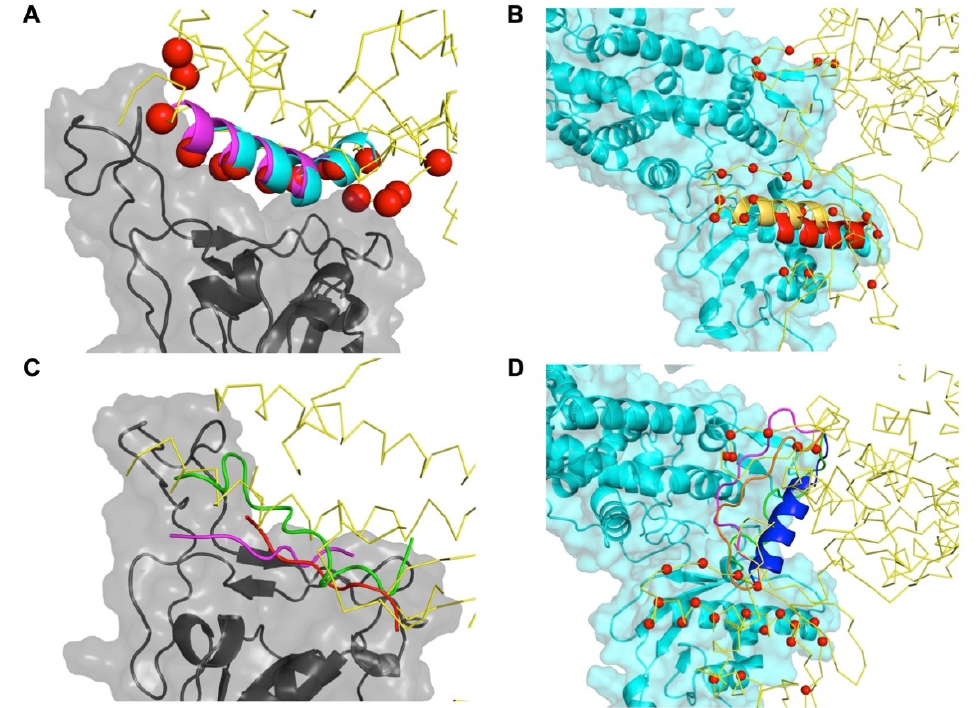
Figure 3. Structural model of the peptides targeting RBD and ACE2 dimerization interfaces. Panels A and C shows structural model of several peptides designed to target SARS-CoV-2 RBD in cartoon representation recapitulating native elements of the interface ( A ) or presenting novel conformations ( C ). RBD is shown in grey and cartoon and surface representation while ACE2 is shown as a trace of C-alpha (yellow); anchor residues are shown as red spheres. Panels B and D show the structural models of peptides targeting ACE2 dimerization in cartoon representation also recapitulating native elements ( B ) or new conformations ( D ). ACE2 is presented both in cartoon and surface (cyan) and as a trace of C-alpha (yellow); anchor residues are shown as red spheres.